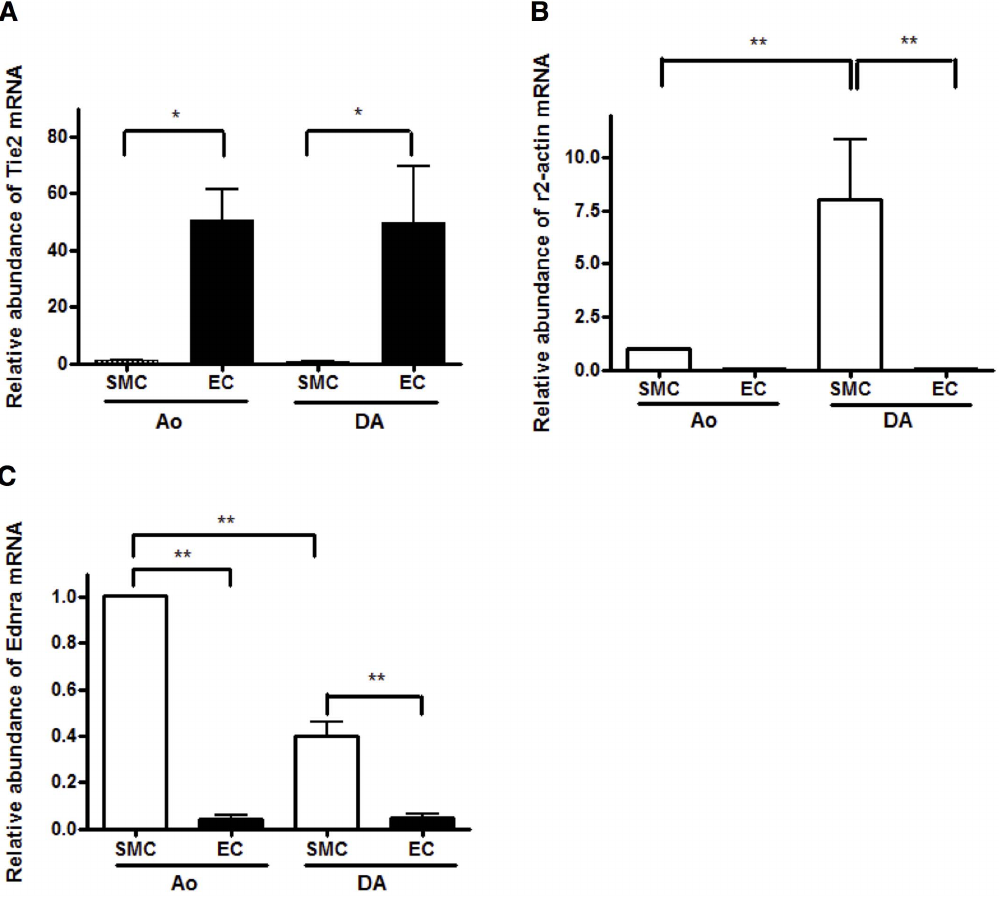
Figure 2. Obvious differences in gene expression between sorted ECs and SMCs. A) The expression levels of Tie2 mRNA were significantly higher in ECs than in SMCs. (* p , 0.05, n=5) B) The expression levels of c 2-actin mRNA were significantly lower in ECs than in SMCs. (** p , 0.001, n=5) C) The expression levels of Ednra mRNA were significantly lower in ECs than in SMCs. (** p , 0.001, n=3).